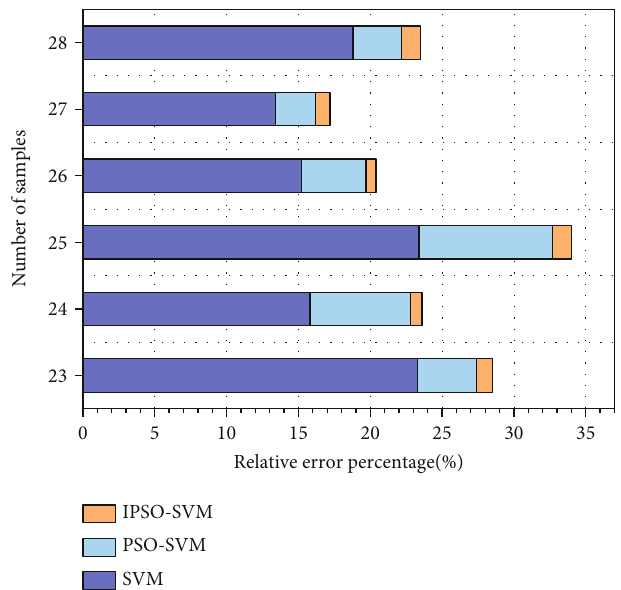
Figure 4: Error range analysis.